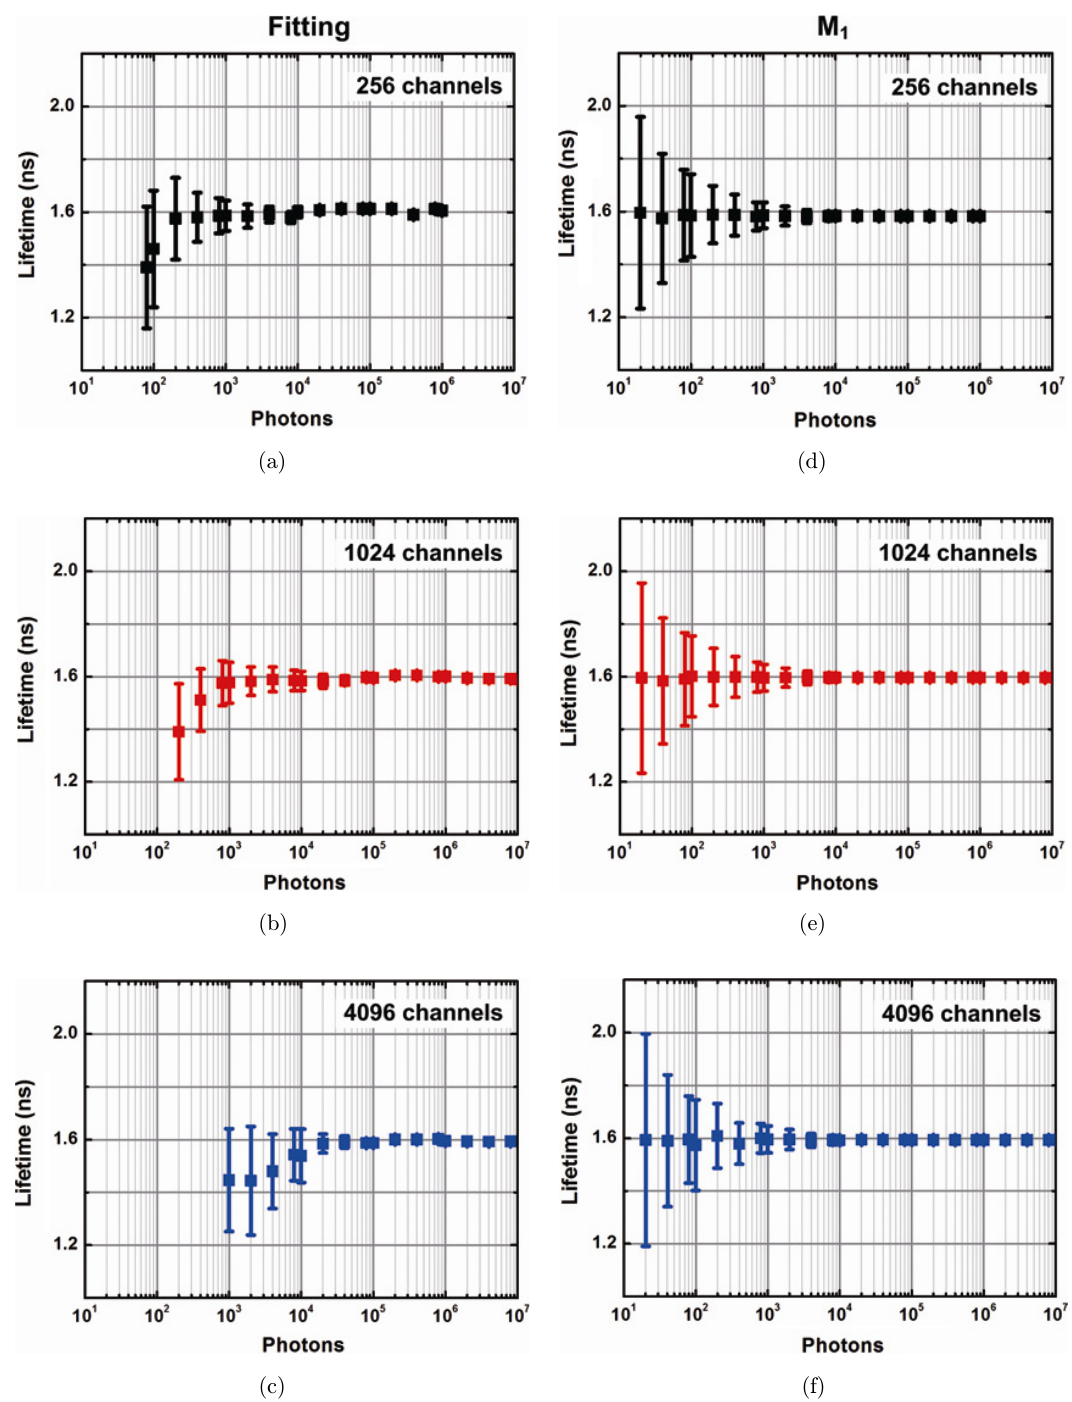
Fig. 3. Accuracy and precision of the lifetime measurement under di®erent signal intensities and di®erent number of time channels. Results from the Fitting and the M 1 methods are shown in the left and right column, respectively. The statistics is from 1000 repeated analysis, and the error bars represent the standard deviation of the corresponding lifetime